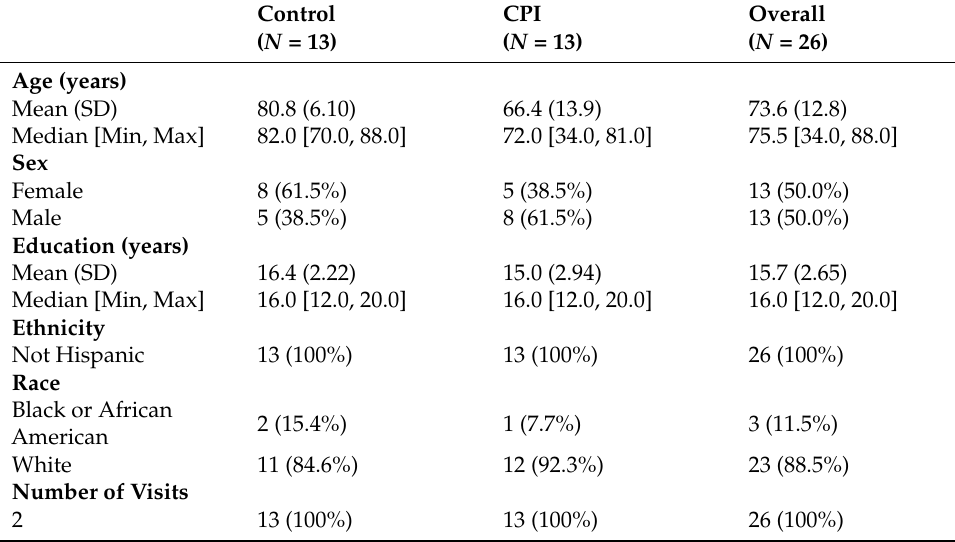
Table 4. ADRC controls vs. CPI group at month